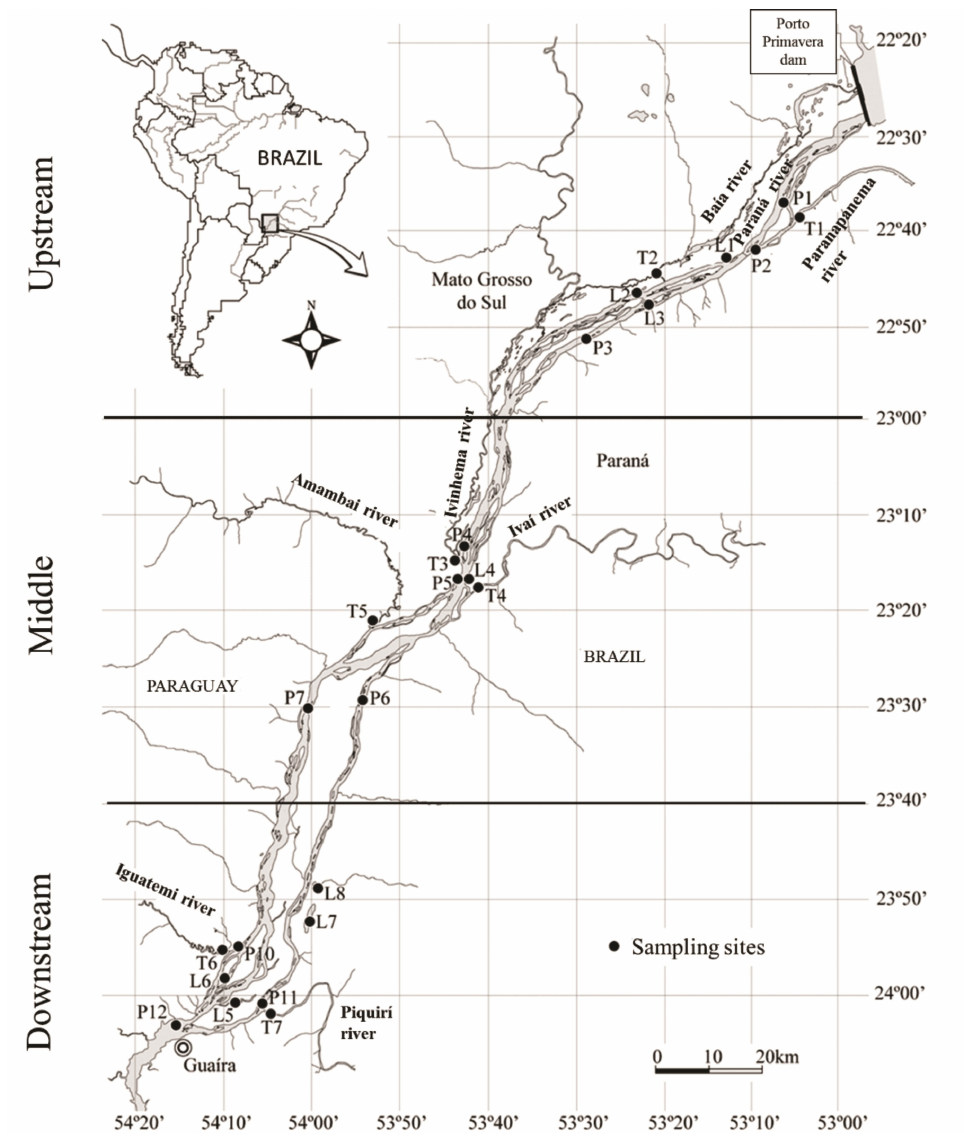
Figure 1. Map of the study area showing the sampling sites in the Paraná River and